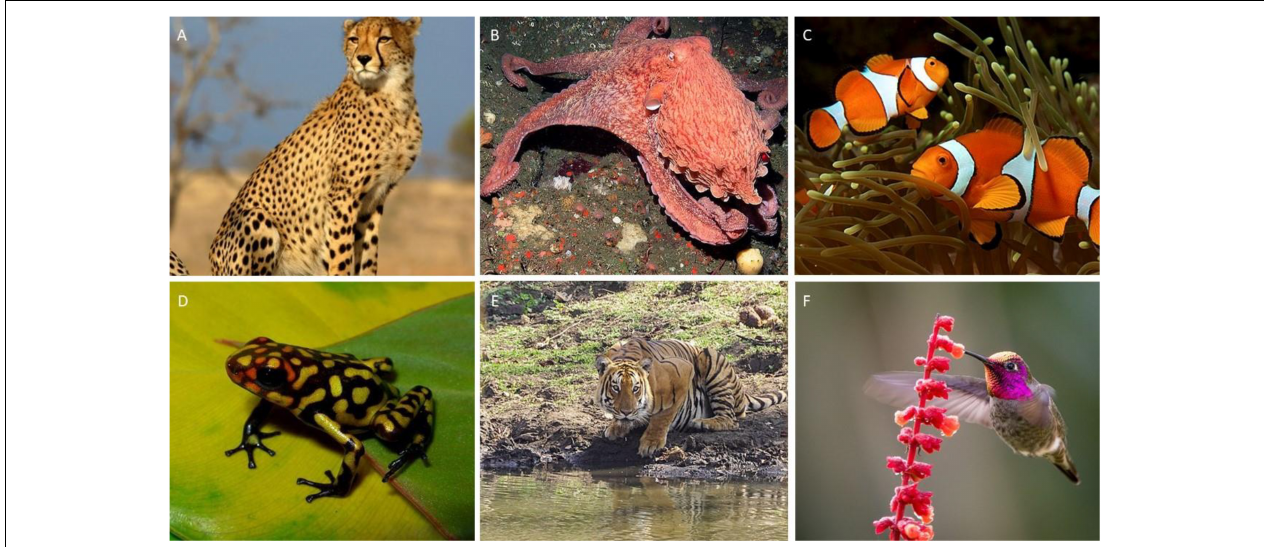
FIGURE 7 | Charismatic and colorful flagship species from around the world used in conservation and restoration campaigns. Clockwise from top left: (A) Acinonyx jubatus (Cheetah in Sabi Sands by James Temple), one example of colorful and charismatic but endangered species used to head conservation campaigns and used often to promote eco-tourism and mammal conservation research in the southern African countries. (B) Enteroctopus dofleini (GFNMS—Giant Pacific Octopus—NOAA). Marine conservation organizations and the Monterey Bay and Seattle aquaria along the west coast of North America have used the Pacific giant octopus in promotional campaigns and merchandize to raise funds for their projects. (C) Amphiprion ocellaris (Clown anemonefish in Papua New Guinea by Nick Hobgood). The clown anemonefish (Amphiprion ocellaris) is instantly recognizable as a representative of tropical coral reefs and a recent study by Boudin et al. (2020) shows the effectiveness of the clownfish as a flagship to encourage conservation practices in young children, particularly in the context of the popular film Finding Nemo. (D) Oophaga histrionica (Harlequin poison frog by Mauricio Rivera Correa), often targeted by poachers for the illegal pet trade due to their striking color patterns. (E) Panthera tigris (Tiger drinking water, Mudumalai National Park by Timothy A. Gonsalves), the iconic symbol of Indian wildlife conservation, with the establishment of protected areas such as national parks and tiger reserves based around tiger populations. (F) Calypte anna (Anna’s hummingbird, UC Berkeley Botanic Garden by Becky Matsubara), with its striking patch of iridescence, is used by University of California Master Gardeners to encourage California residents to convert monoculture residential lawns to native wildlife supporting